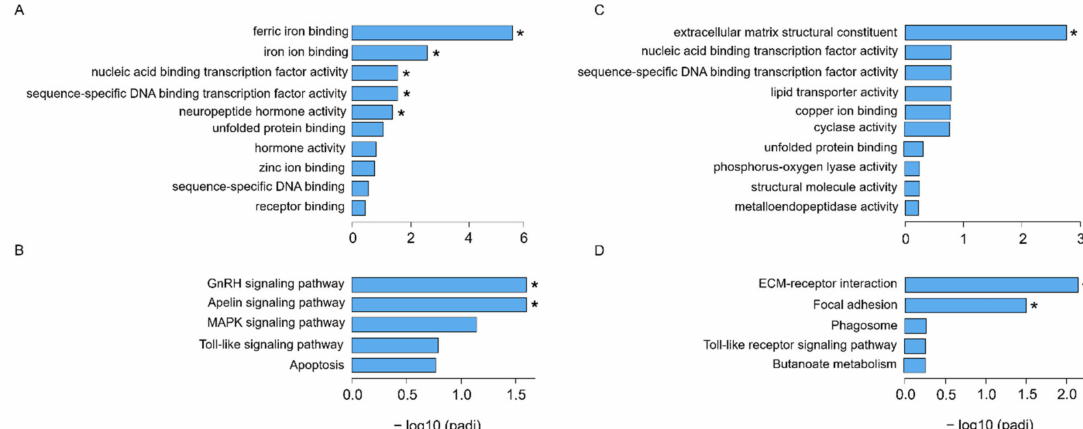
Figure 2. Top GO molecular function (MF) pathways in the brains of juvenile rainbow trout exposed to ( A ) 15 ng/L and ( C ) 30 ng/L bifenthrin, and KEGG pathways from trout exposed to ( B ) 15 ng/L and ( D ) 30 ng/L bifenthrin. The asterisks denote statistically significantly differences between exposure treatment groups and controls (FDR <